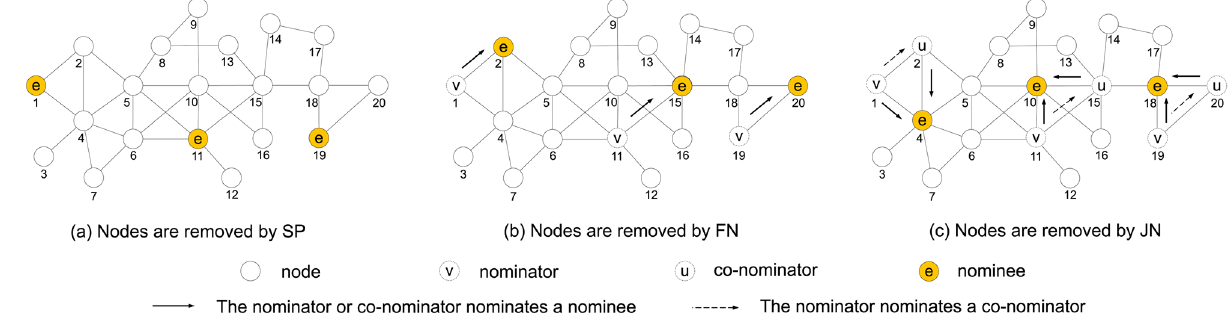
Figure 1. Illustration of three decentralized vital node identification